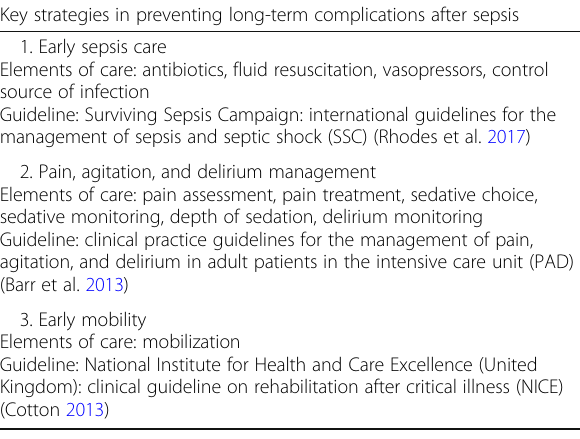
Table 2 Key strategies in preventing long-term complications after